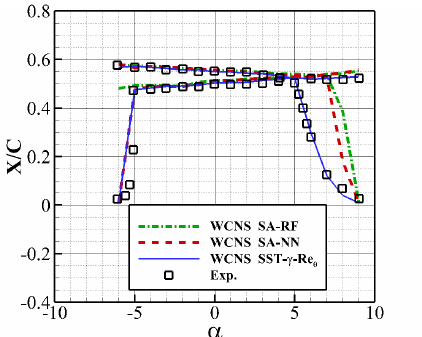
Figure 10. S809 transition situation predicted with different models.